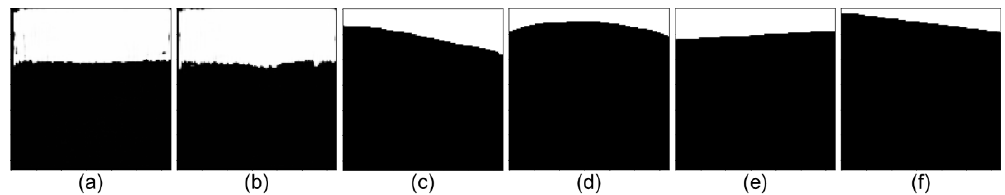
Figure A7. The predictions of the transfer trained network corresponding to the views in Figure A1, ( a ) refers to the view of left Mastcam-Z Camera captured by the Perseverance, ( b ) refers to the view of right Mastcam-Z camera captured by the Perseverance, ( c ) refers to the view of rear hazard avoidance camera captured by the Perseverance, ( d ) refers to the north edge of the “Home Plate” plateau captured by the Spirit, ( e ) refers to the rim of “Erebus Crater” captured by the Opportunity, ( f ) refers to the Meridiani Planum region captured by the navigation camera of the Opportunity. Table A1. The real-time and computing power properties of the related studies.